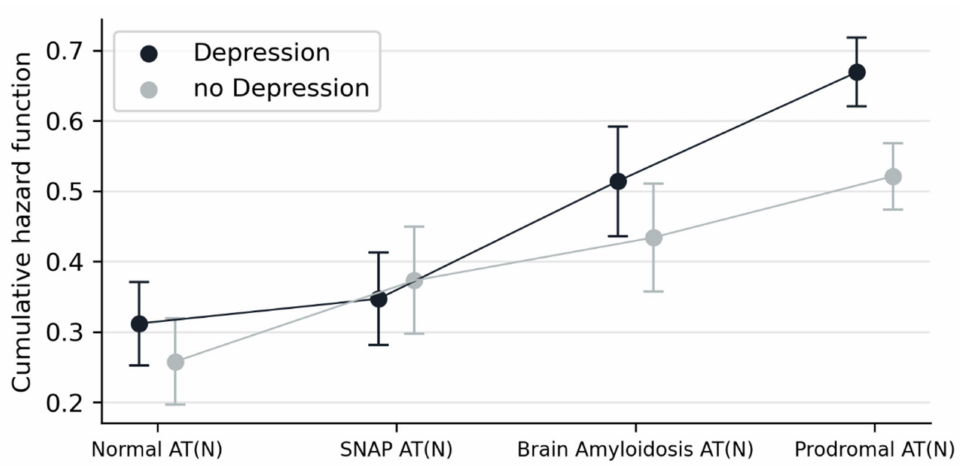
Figure 2. Estimated marginal means of cumulative hazard function when combining effects of AT(N) profiles and depression on conversion to dementia. Note: cumulative hazard function adjusted by age, sex, years of formal education, amnestic profile (yes/no), probable MCI (yes/no) APOE ε 4 carrier (yes/no) and MMSE at baseline a MMSE: Mini-Mental State Examination; SNAP: Suspected Non-Alzheimer’s